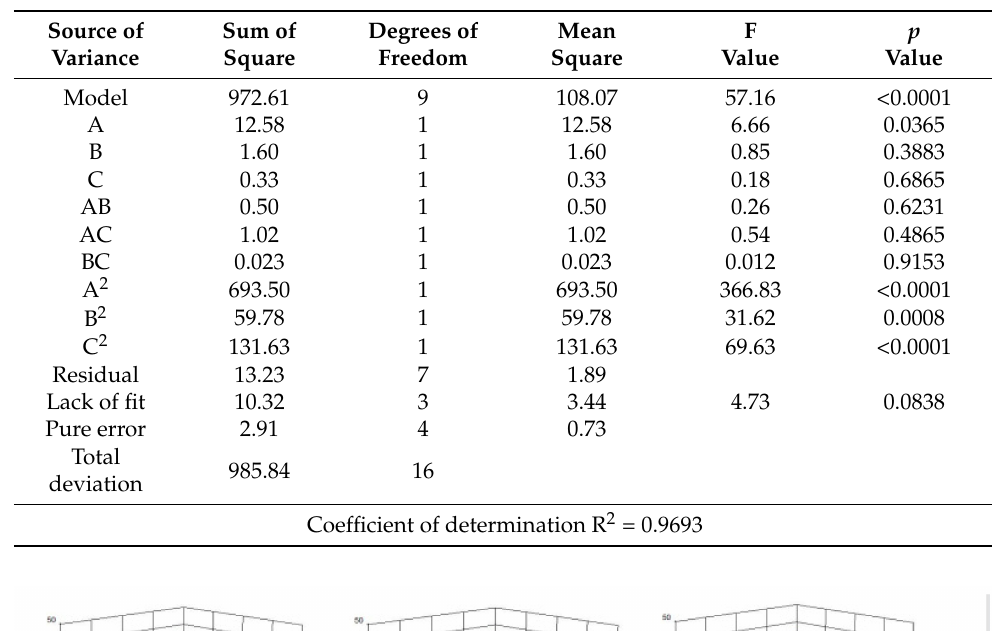
Table 3. Analysis of variance.